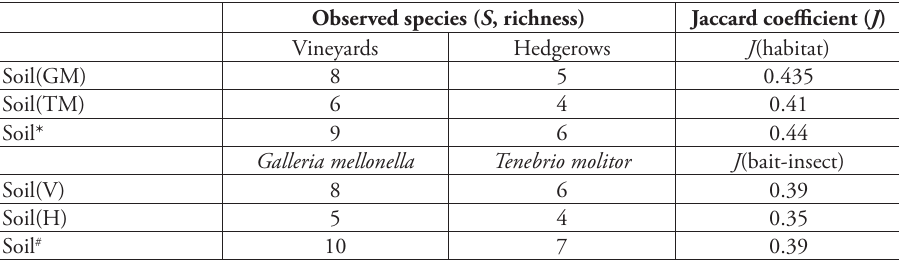
Table 2. Entomopathogenic fungal species richness and similarities amongst isolations from different habitat-types and